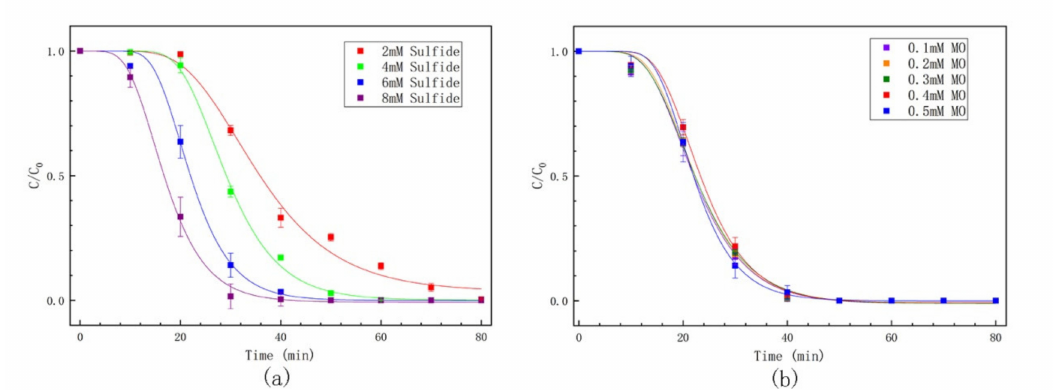
Figure 7. ( a ) Degradation of MO (0.5 mM) by 2, 4, 6, and 8 mM sulfide. ( b ) Degradation of 0.1, 0.2, 0.3, 0.4, and 0.5 mM MO by sulfide (6 mM). The dosage of materials was 100 mg/L, pH = 7.4, and the temperature was 30 ◦